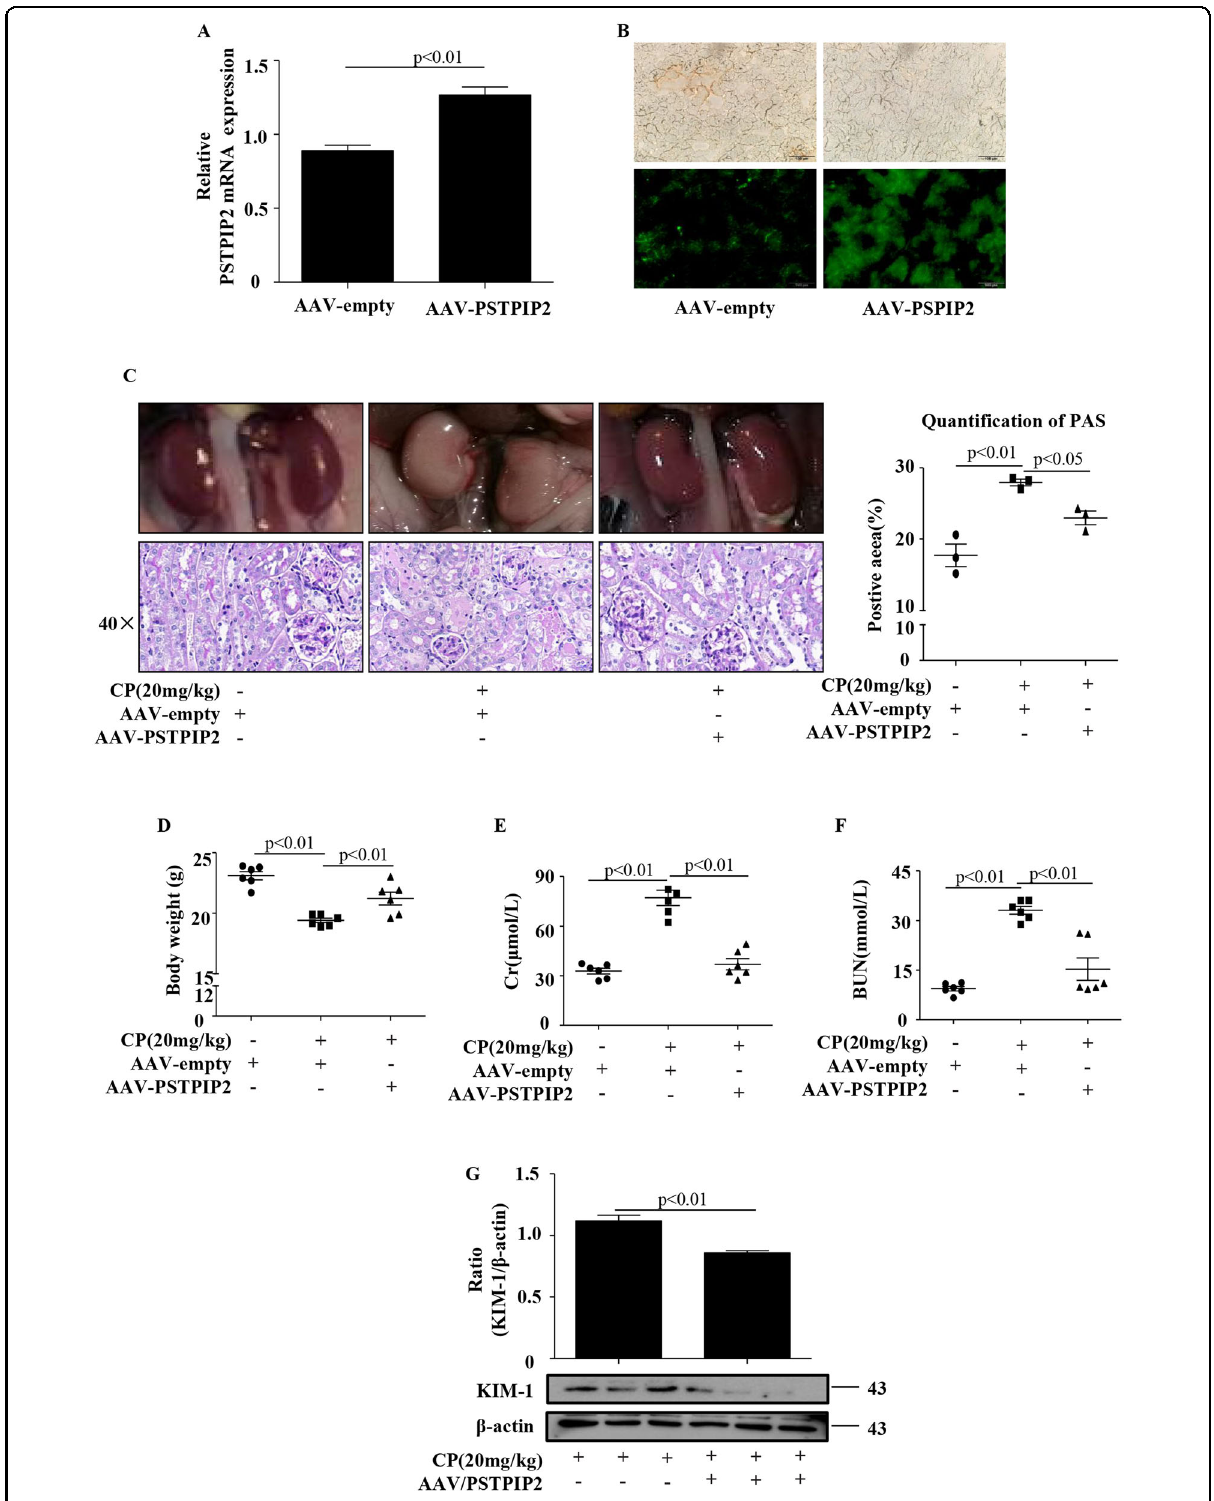
Fig. 3 PSTPIP2 administration suppressed CP-induced kidney dysfunction. a PSTPIP2 mRNA levels in kidney tissue analysed by quantitative real- time PCR. b Representative ef fi cient transfection of rAAV9 – PSTPIP2 – eGFP in kidney tissue detected by fl uorescence microscopy. c Representative macroscopic appearance of the kidney. Kidney tissues were stained with periodic acid-Schiff and renal tubular damage was quanti fi ed. d Body weight in mice 72 h after CP injection. e Serum creatinine (Cr) assay. f Blood urea nitrogen (BUN) assay. g The protein levels of KIM-1 were detected by western blot. Similar results were obtained in 3 independent experiments with 10 mice per